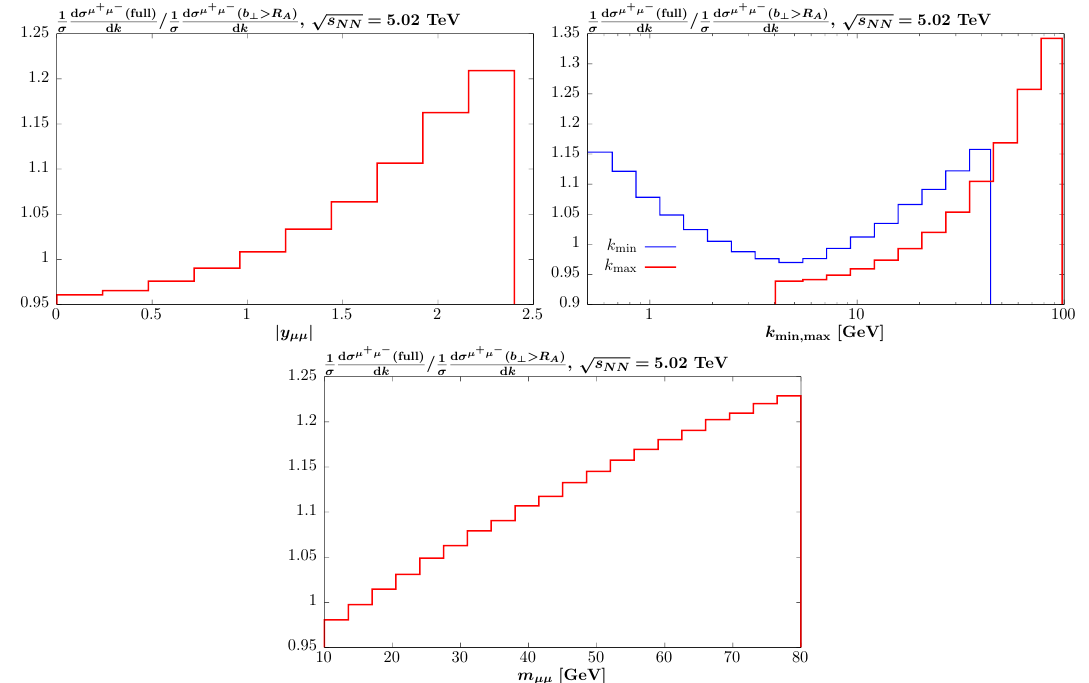
Figure 2: Normalized differential cross sections as a function of the (top left) dimuon rapidity, (top right) maximum photon energy ( k ( k ), and (bottom) dimuon invariant mass, calculated using a modified version of min SuperChic 4 [ 1 ] . The ratio of the full result to the case with the b imposed is given; in both cases the survival factor is